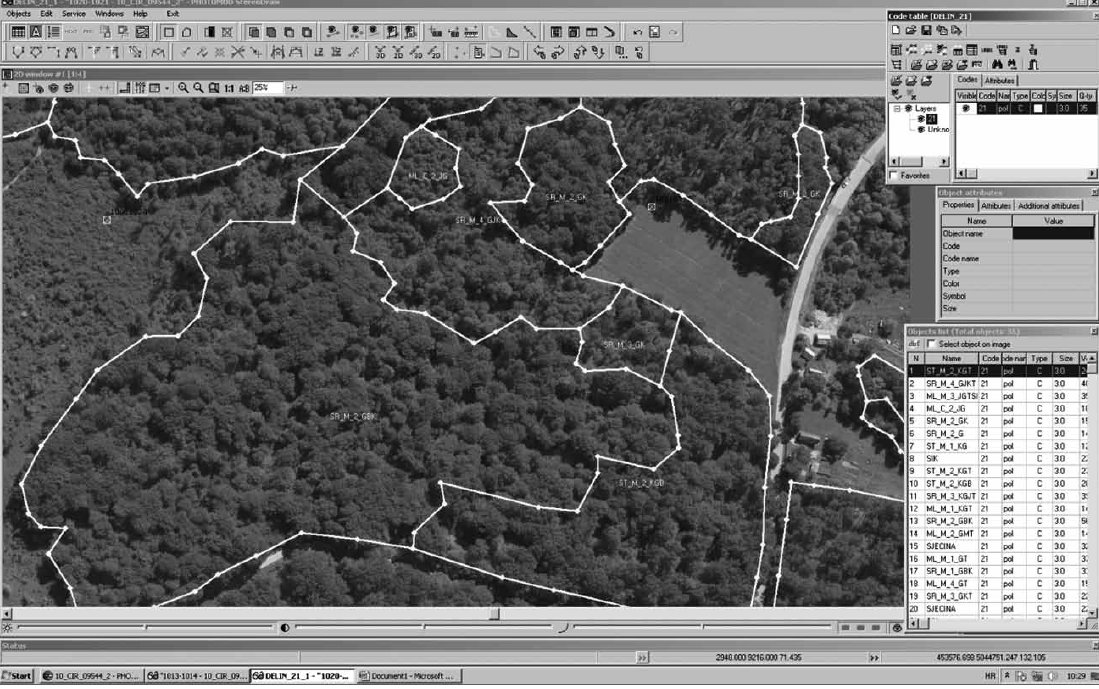
FIGURE 6 An example of strata delineated on digital aerial images of GSD 10 cm shown in 2D window of StereoDraw module at mitigation of 25